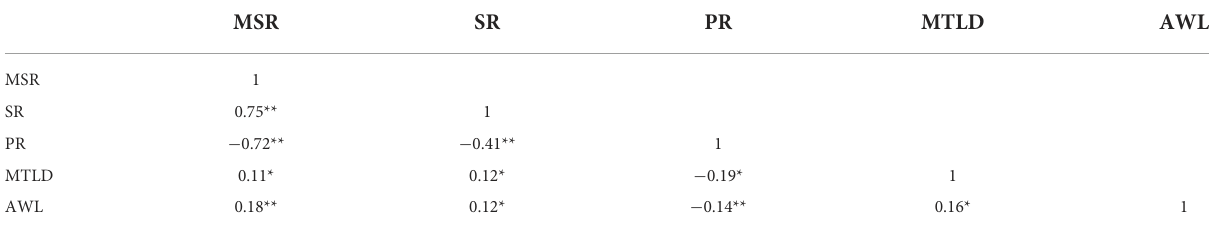
TABLE 4 Correlation between variables for all speakers.